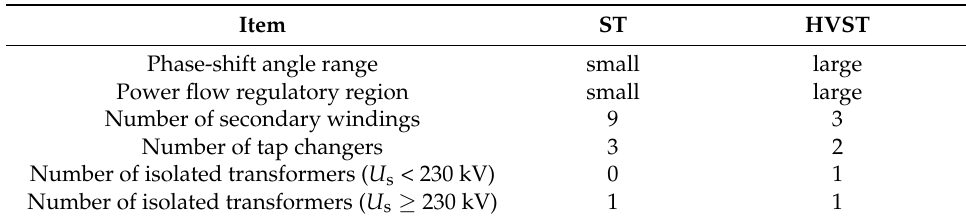
Table 1. Comparison between the ST and the